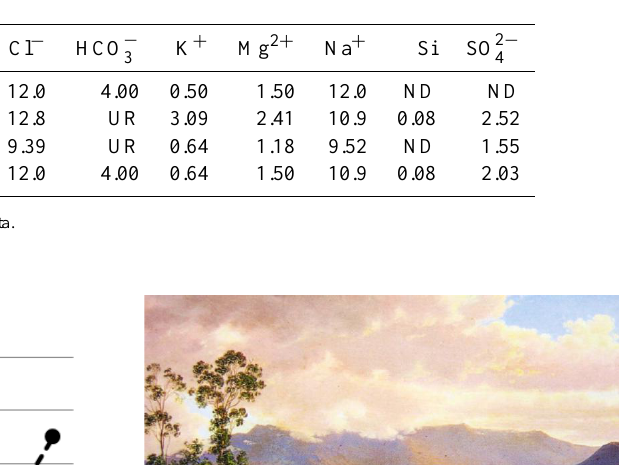
Table 3. Rainfall composition (molL − 1 × 10 5 ).